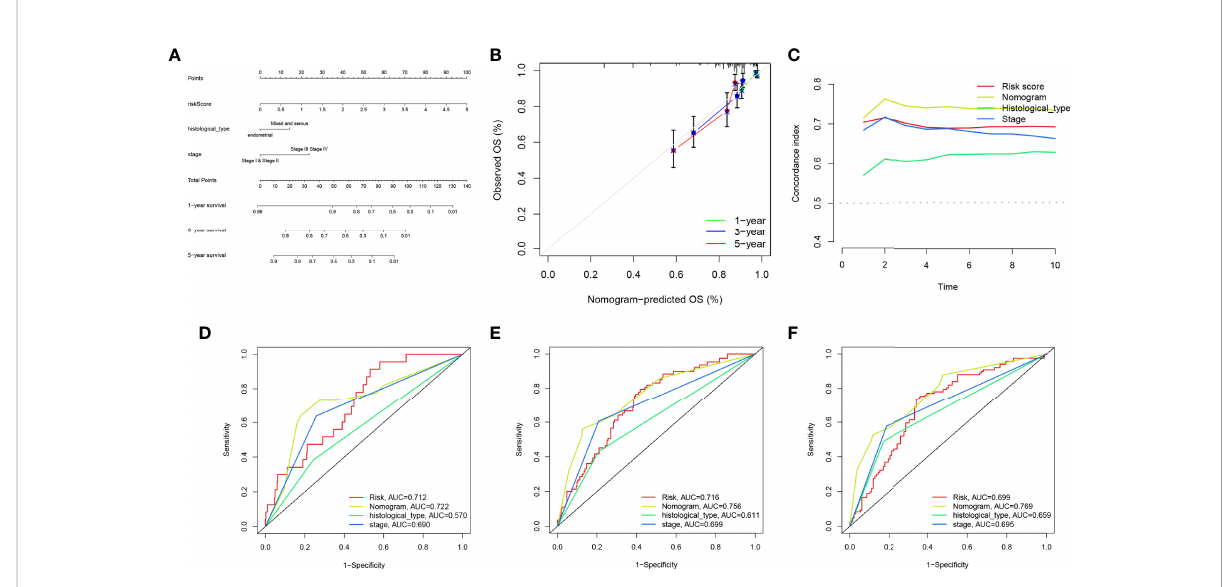
FIGURE 9 Construction and evaluation of the nomogram. (A) The nomogram was developed for clinical application. (B) Calibration curves of the nomogram we developed. (C) The nomogram achieved a signi fi cantly higher c-index value than other clinical factors, meaning a better predictive accuracy for endometrial carcinoma (EC). (D – F) The area under the curve (AUC) values of the nomogram for 1-, 3-, and 5-year overall survival (OS) were higher than 0.7 and other clinical factors, indicating that the nomogram was